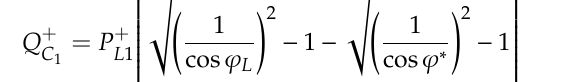
Figure 5. Impedance model of the system, thyristor-controlled L and C -type filter (TCL-CTF), and traction net.